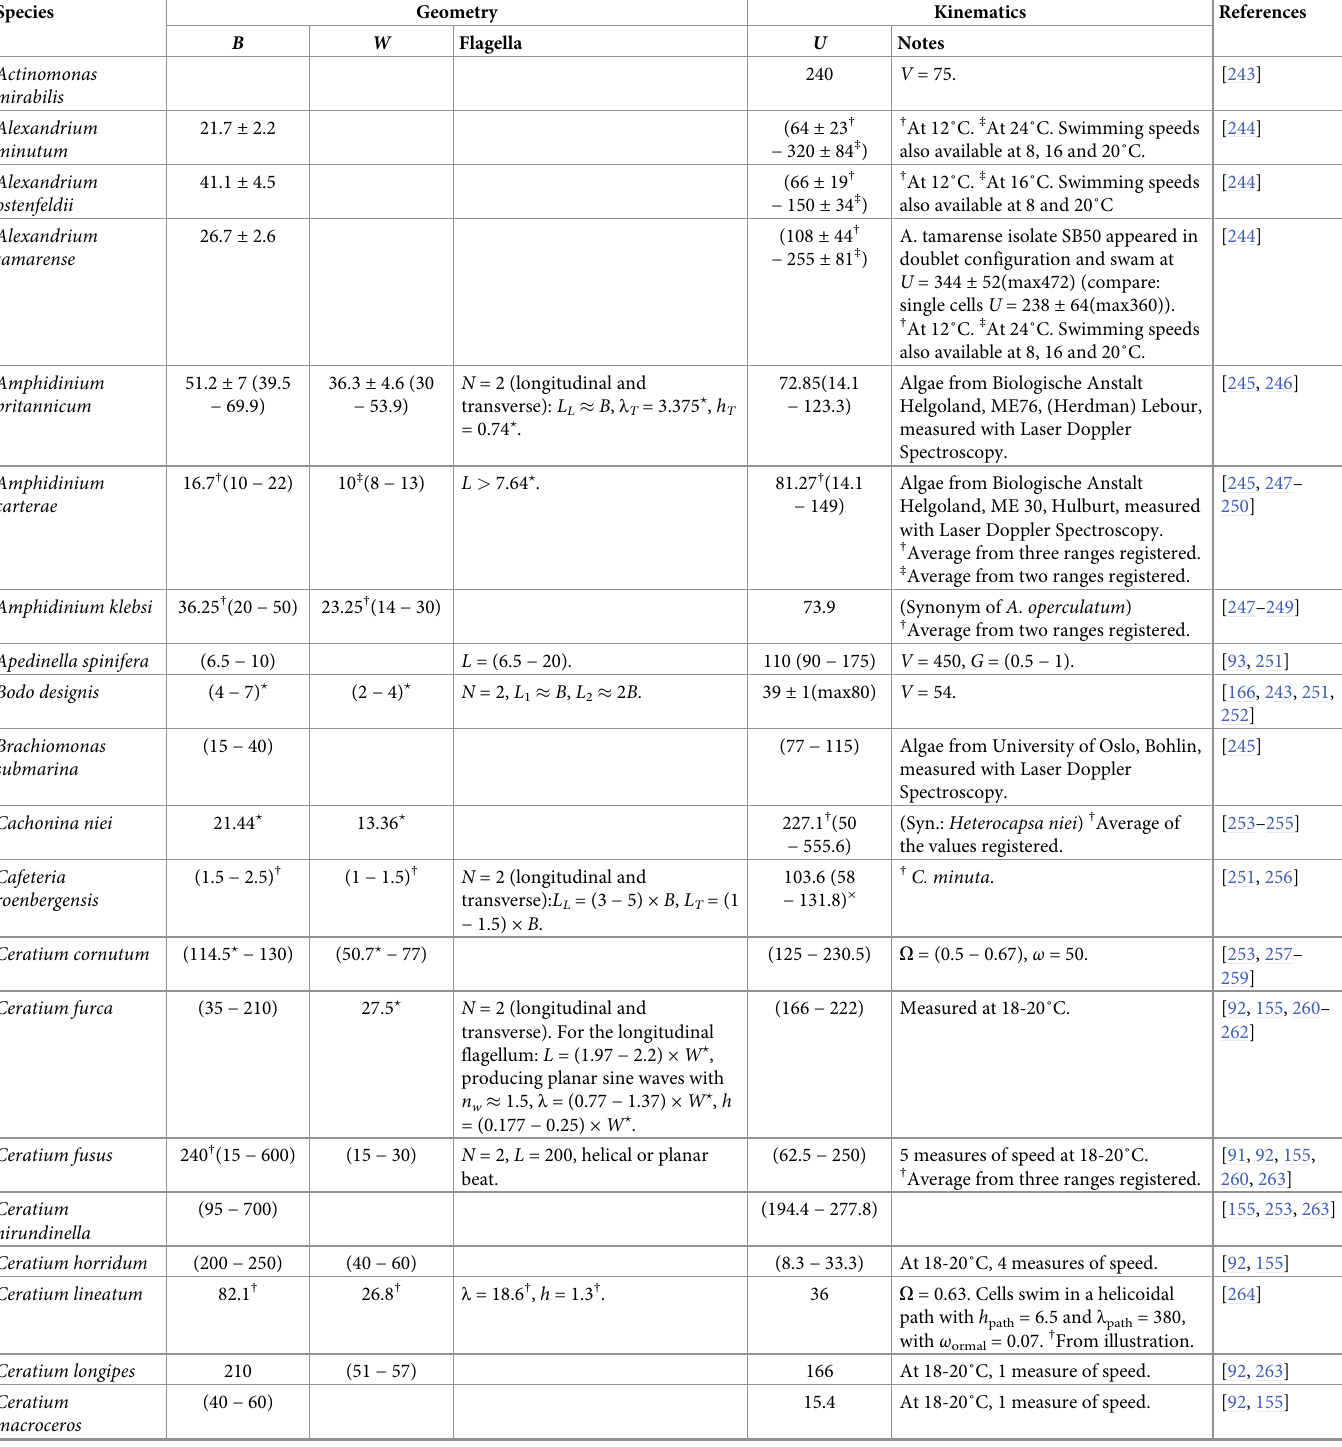
Table 7. Data for swimming flagellated